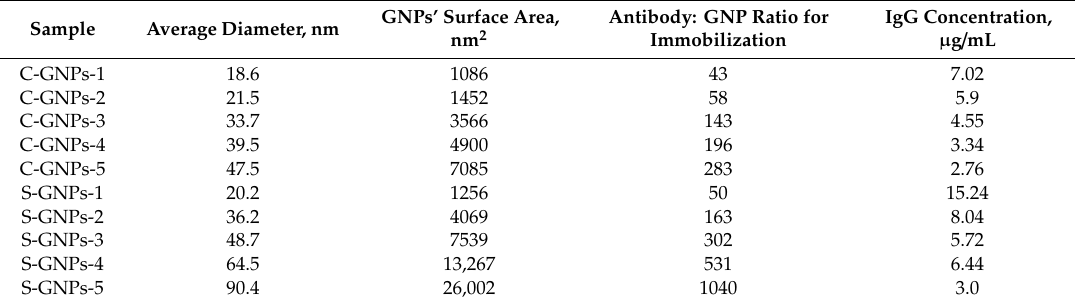
Table 5. The choice of the antibody: GNP ratio for their conjugation.